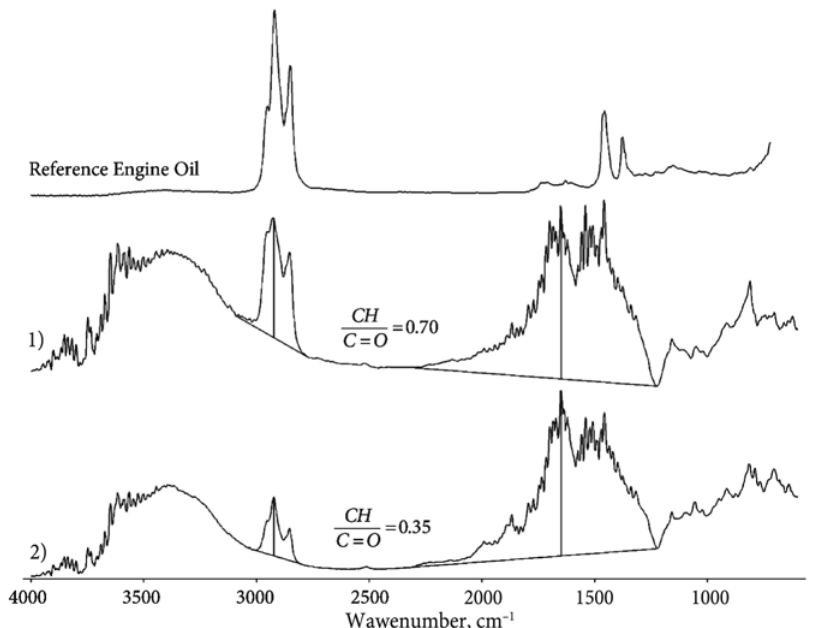
Fig. 5. FTIR spectra of: (1) the dark-coloured; and (2) the background measuring fields depicted in Figure 4. Engine oil is provided as analytical reference